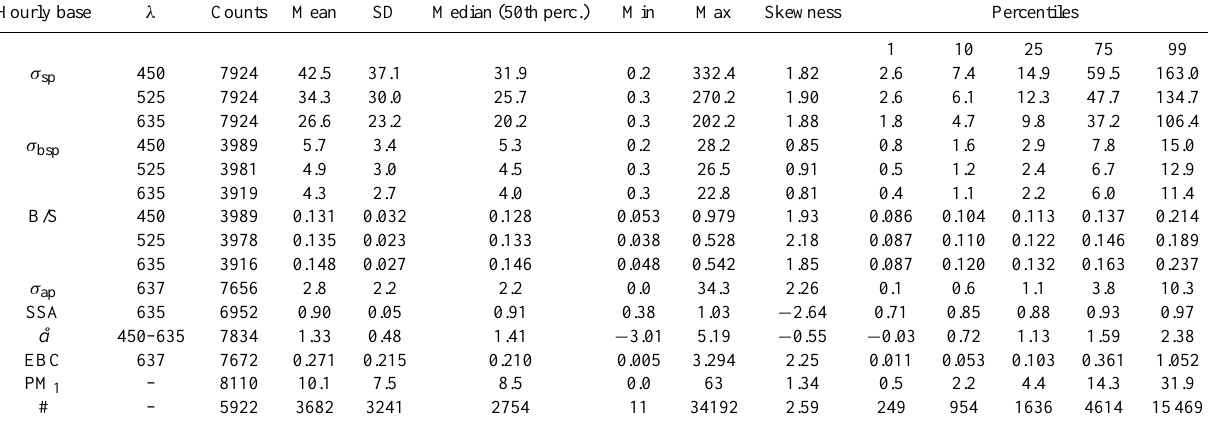
Table 1. Statistics of the considered aerosol components and parameters for the period November 2009 – October 2010 at Montseny site. The wavelength ( λ ) is given in [nm]; Scattering ( σ sp ), backscattering ( σ bsp ) and absorption coefficients ( σ ap ) are given in [Mm − 1 ]; Backscattering-to-scattering ratio (B/S), single scattering albedo (SSA) and ˚Angstrom exponent ( ˚a ) are dimensionless; Equivalent Black Carbon (EBC) and PM 1 concentrations are given in [µgm − 3 ], and particle number (#) is given in [cm − 3 ]. Statistics is based on hourly mean